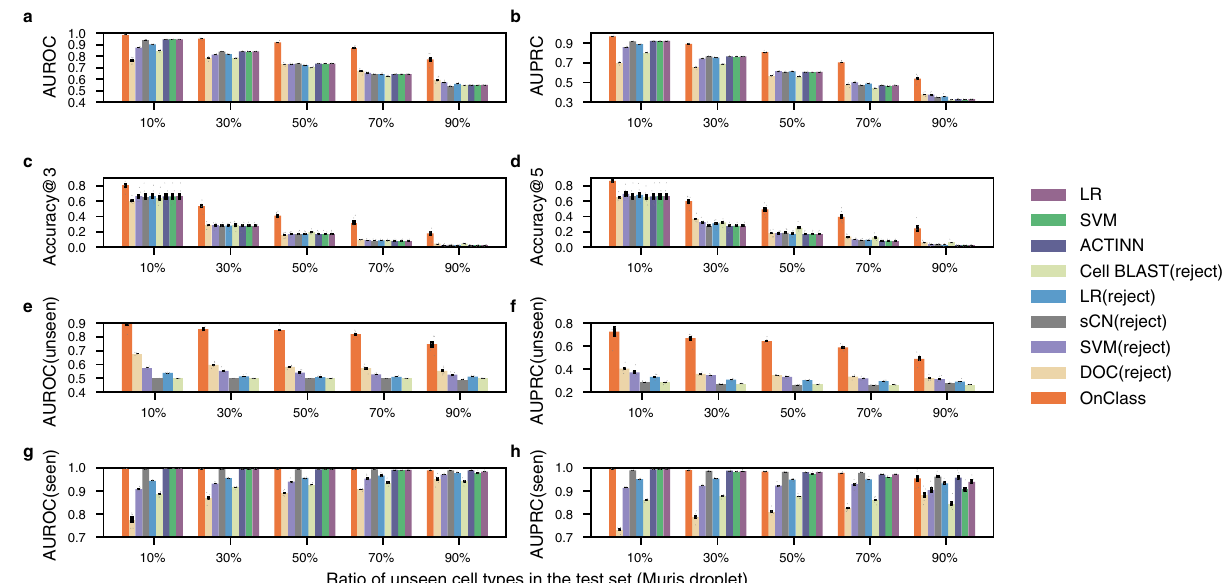
Fig. 2 Performance of OnClass on unseen cell type annotation. a – h Bar plots comparing OnClass and existing methods in terms of AUROC ( a ), AUPRC ( b ), Accuracy@3 ( c ), Accuracy@5 ( d ), AUROC on unseen cell types ( e ), AUPRC on unseen cell types ( f ), AUROC on seen cell types ( g ), and AUPRC on seen cell types ( h ) in Muris droplets. x -axis shows the proportion of unseen cell types in the test data. Error bar represents standard errors across 5 replicates. Mean is used to measure the centre for the error bar.